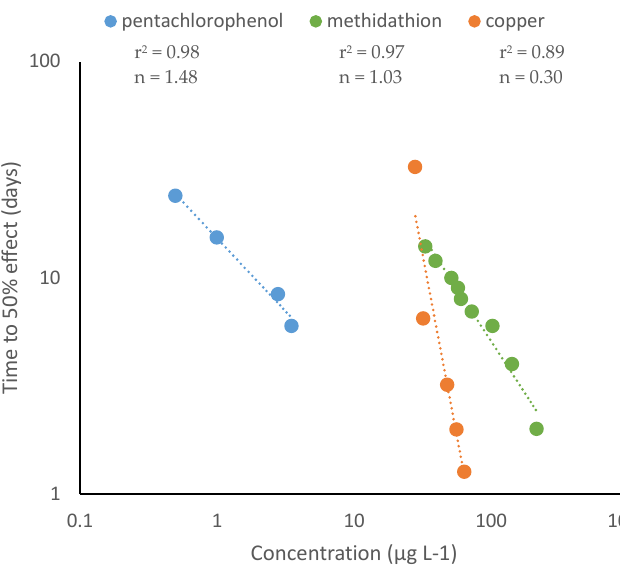
Figure 1. Time-dependent toxicity identified by log-log regression. Time-cumulative toxicity of the biocide pentachlorophenol to the amphipod Gammarus pulex (after Ashauer et al. 2007 [30]). Toxicity of the insecticide methidathion on guppies ( Poecilia reticulata ) is time-dependent and follows Haber’s rule (after Legierse et al. 1999 [22]). The toxicity of copper to Daphnia magna is mainly dose-dependent (after Hoang et al. 2007 [29]).